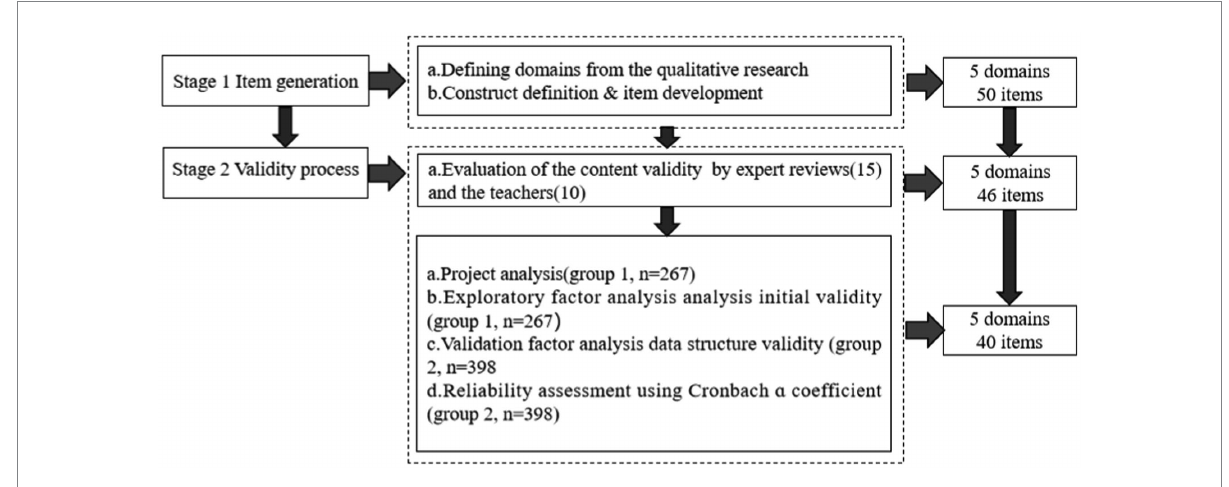
FIGURE 1 The TCLQ-PPE research